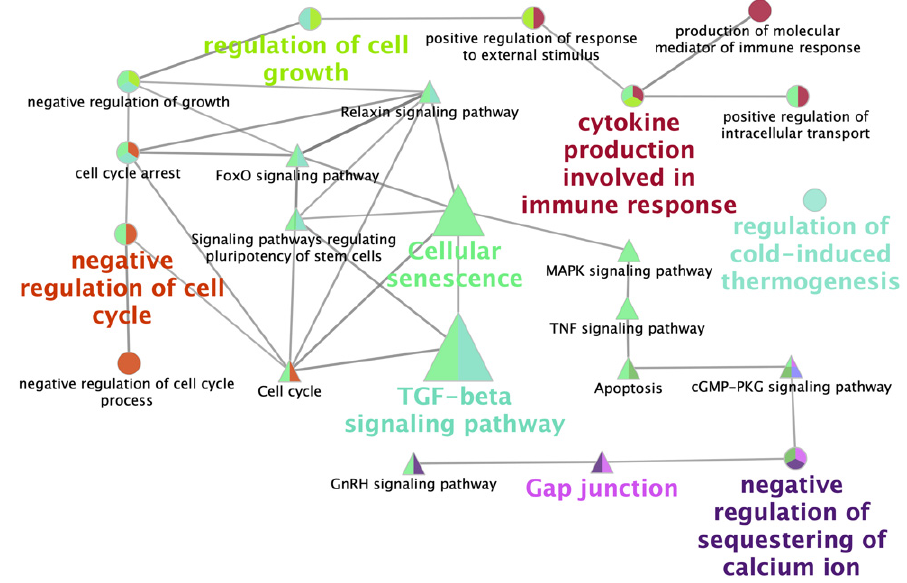
Figure 4. Functionally grouped network view of enriched pathways obtained from the analysis of differentially expressed genes in vitrified blastocysts compared to control embryos. The networks were obtained with the ClueGo v2.0.3 plug-in from the Cytoscape v3.0.0 software. Nodes are colored according to the grouping of related pathways, and groups are labelled according to the most significant pathway of the group. Edges indicate interactions between pathways and the node size represents the enrichment significance, where the largest nodes correspond to the highest